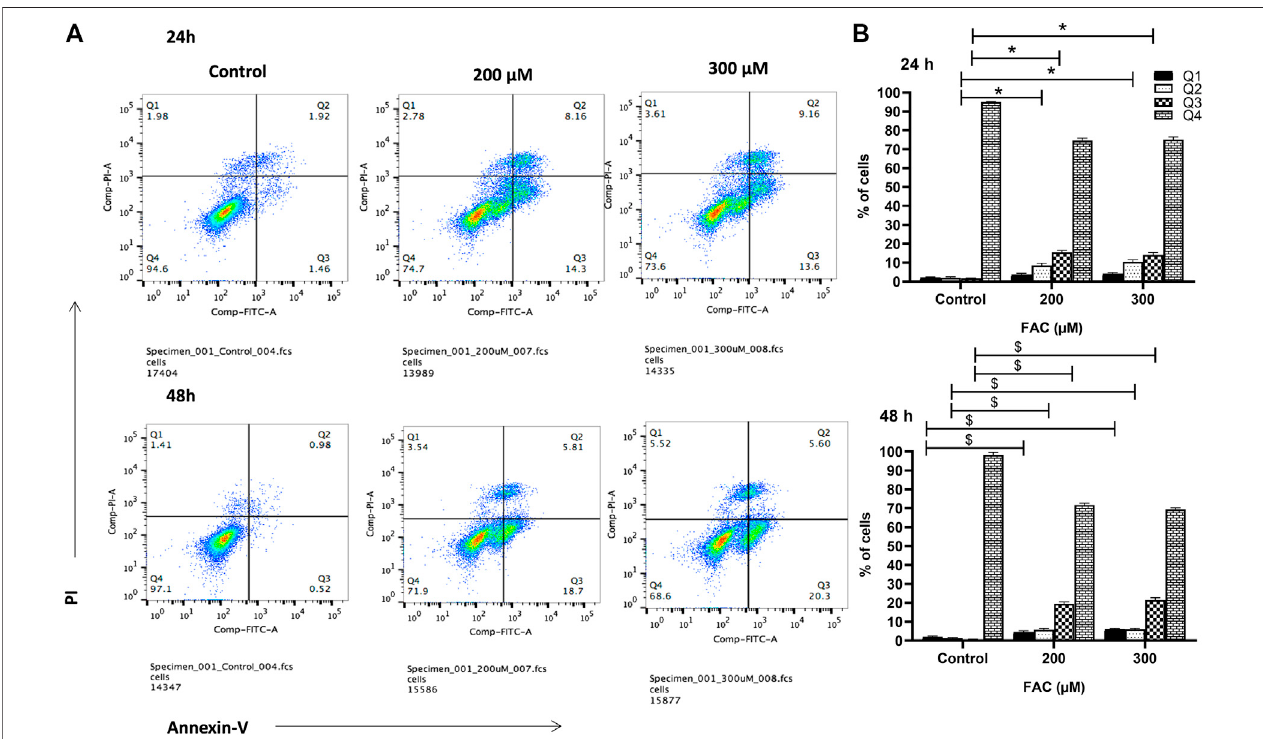
FIGURE 3 | Iron overload induces apoptosis in chondrocytes. (A) Percentage pro-apoptotic and apoptotic C-20A/4 cells was examined following treatment with 200or300 µMofFACand24or48 husingthePI-annexinVstaining-based fl owcytometrymethod. (B) Mean±SDpercentageofpro-apoptoticandapoptoticC-20A/4 cellswascalculatedbasedonthreeindependentexperimentsasin (A) .*, $ denotesstatisticalsigni fi canceat p < 0.05aspertheindicatedgroup vs. itsuntreatedcontrolat 24 and 48 h respectively. Untreated cells cultured under the same conditions served as negative